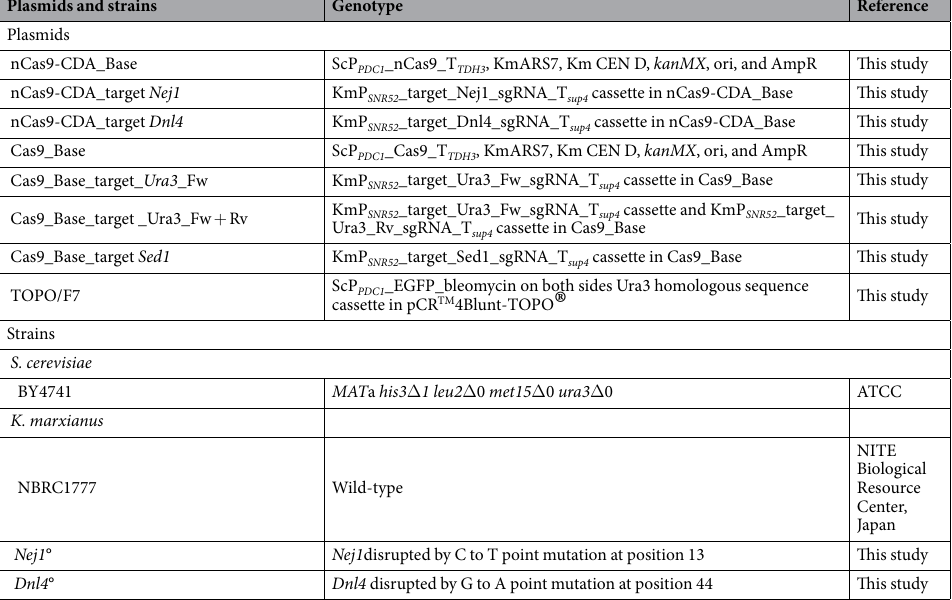
Fig. S3 and S4. Vector assembly was performed by PCR using the In-fusion cloning method (Takara Bio, Shiga, Japan). The vector backbone was designed to contain KmARS7, KmCEN-D and selectable marker kanMX , which encodes G418 resistance. For CRISPR-Cas9 (Cas9_Base) and Target-AID (nCas9-CDA_Base) vectors, a gene encoding human-optimized nCas9-PmCDA1 or Cas9 15, 16 (respectively) was placed between ScP PDC1 and the TDH3 terminator (ScT TDH3 ) on the vector backbone.